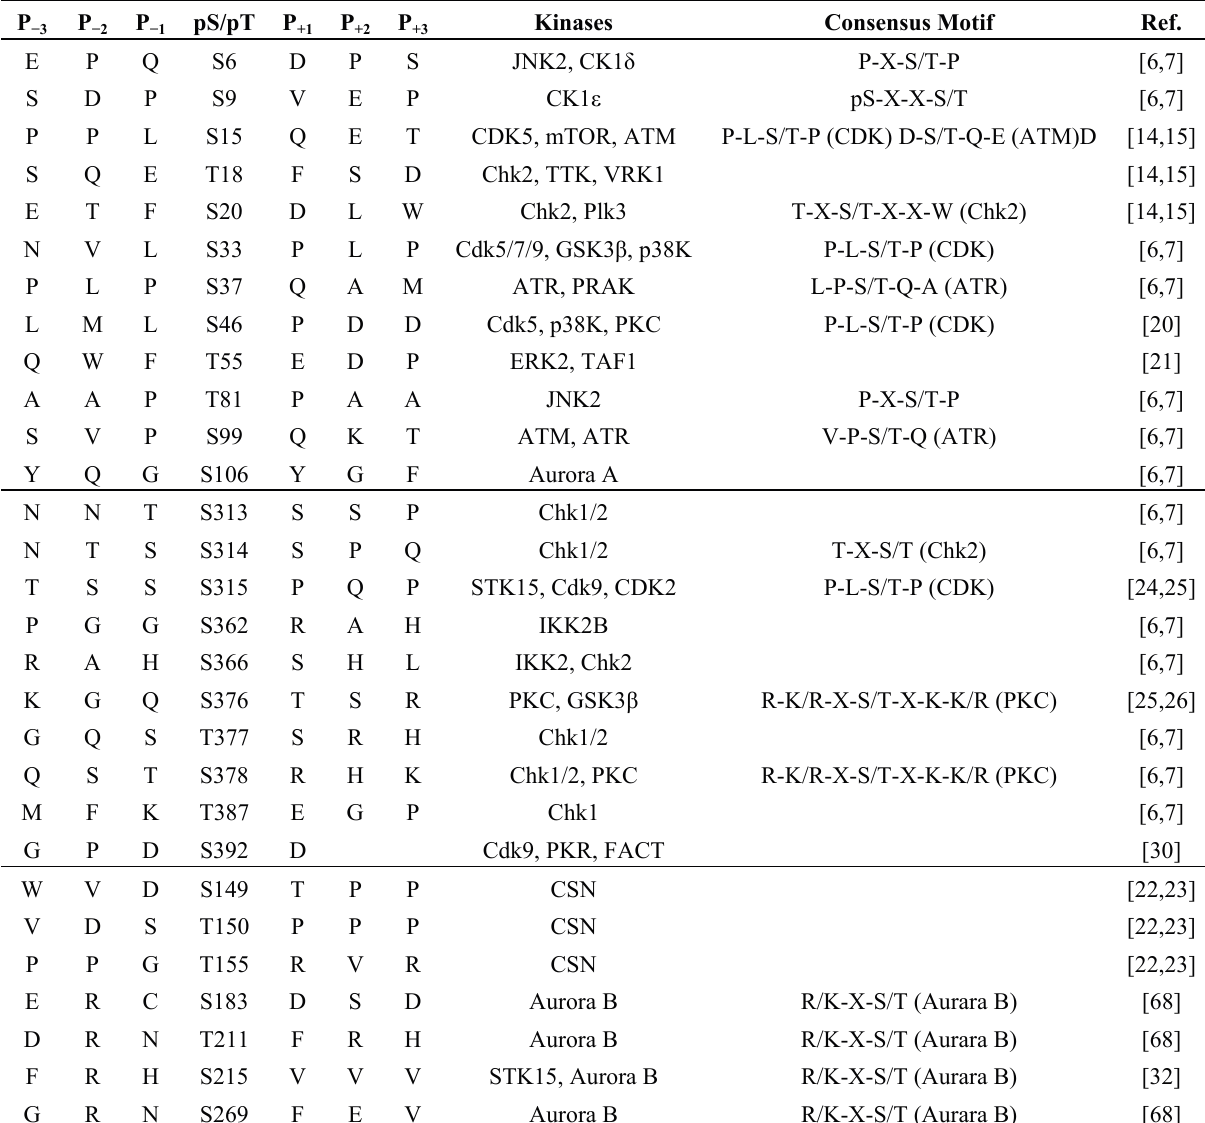
Table 1. Phosphorylation site motifs for